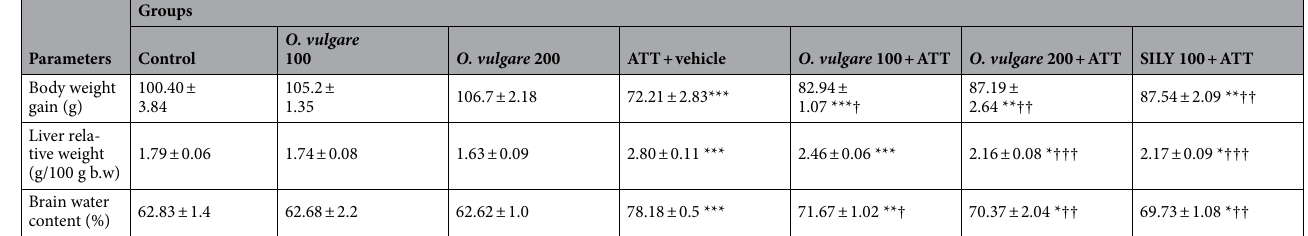
Table 2. The modulatory effects of O. vulgare on body weight, liver relative weight, and brain water content in the HE-induced rat model. Values are means ± SEM. O. vulgare : Origanum vulgare , SLY: silymarin. * p < 0.05; ** p < 0.01; *** p < 0.001 (vs. the negative control group); † p < 0.01; †† p < 0.01; ††† p < 0.001 (vs. the HE positive control group, which received